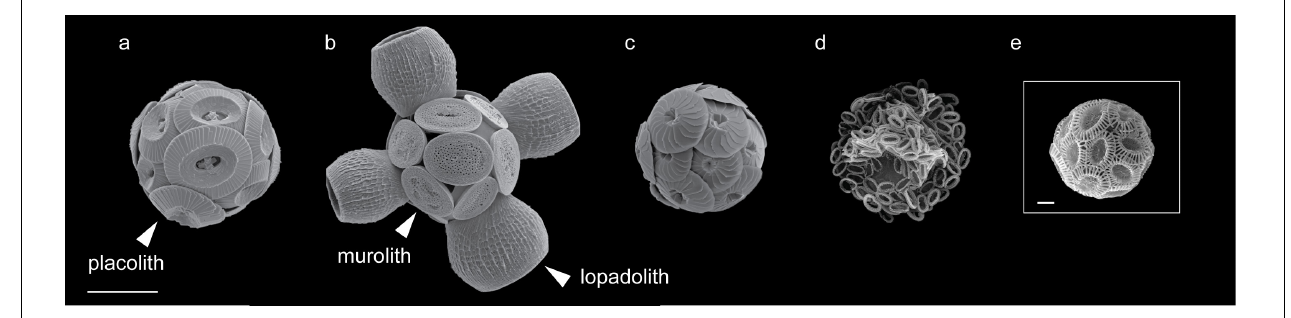
FIGURE 1 | Scanning electron microscopy images of coccolithophore species included in this study. (a) Coccolithus braarudii , (b) Scyphosphaera apsteinii , (c) Calcidiscus leptoporus , (d) Chrysotila carterae, and (e) Emiliania huxleyi . All species included are placolith bearing with the exception of S. apsteinii (b) which bears disk-shaped muroliths and barrel-shaped lopadoliths, representative examples of each coccolith type are labeled (arrowhead). Scale bars represent 10 µ m (a–d) and 1 µ m (e) .